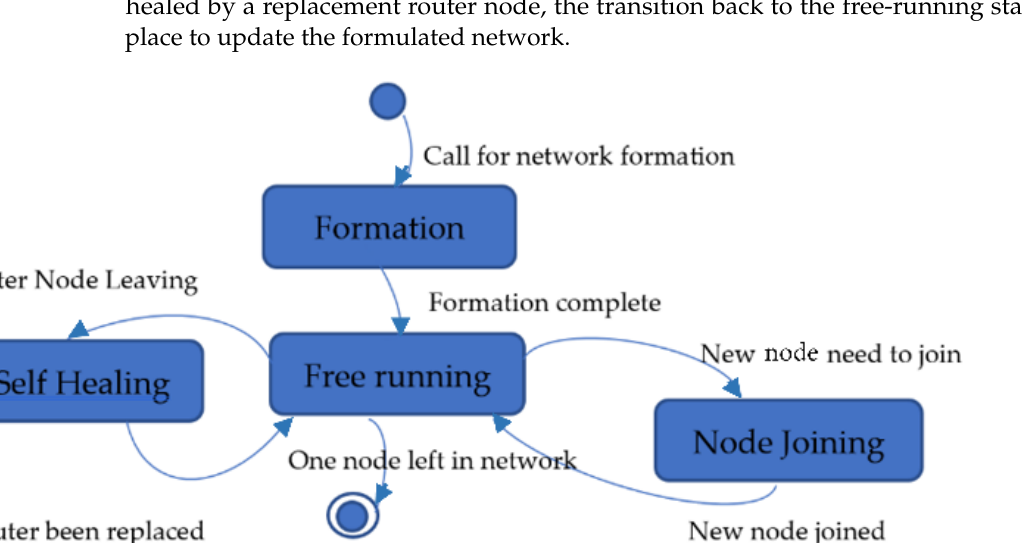
Figure 3. Self-X grouping phases in the detailed state machine. • Self-Formation: this is a compound state that has sub-states running; these are the fitness model, assigning cluster head (CH), cluster head at level 1 (L1), connected child node ID to cluster head, rest of router nodes, a router ID (RID) at level n (Ln), and connected child node ID to router ID at level n. The fitness model sub-state is initiated by exchanging data among the nodes, leading to calculations of the sub-state which has as its entry a data set to perform the required calculations. The outcome of the calculations are the fit values that can trigger the transition to the sub-state of router nodes ID with their fit values. The fitness model sub-state transits to assigning the cluster head sub-state where the entry is the set of fit values to perform, assigning the fittest value as the cluster head. Now that the cluster head has been assigned at